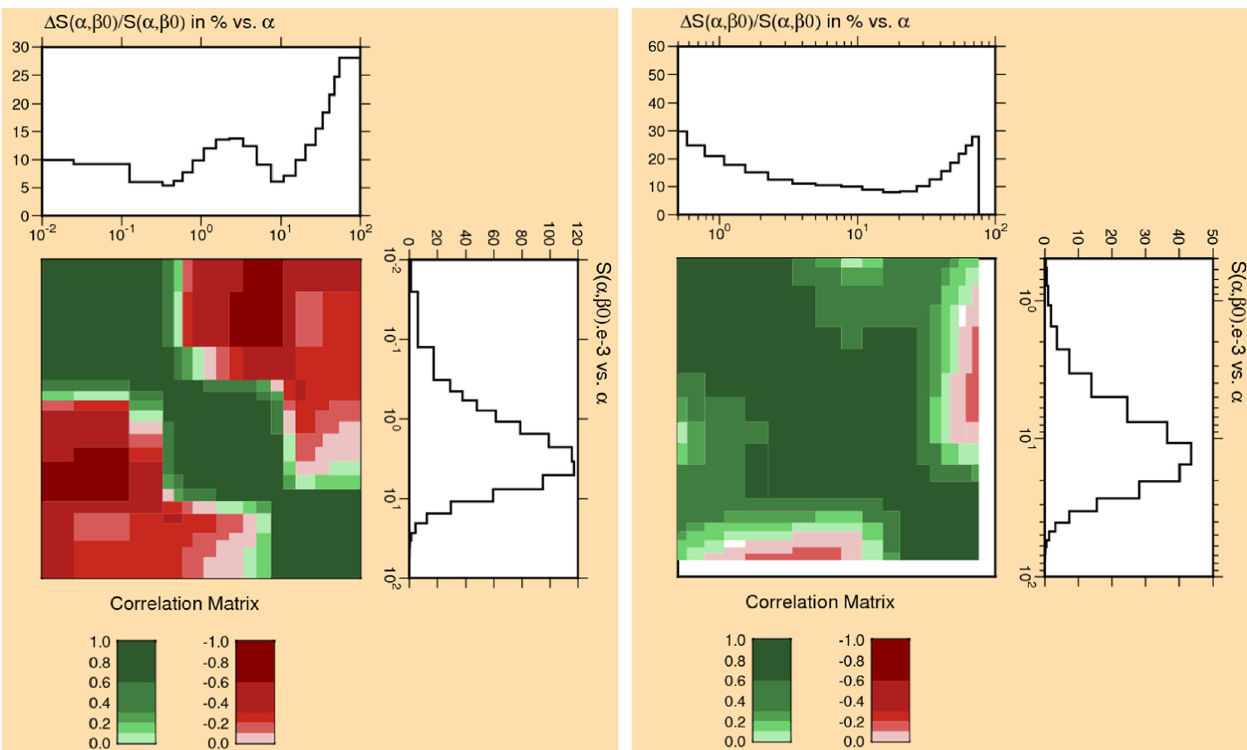
Fig. 6. Relative uncertainties and correlation matrix of the S ð a ; b 0 Þ functions for b =1.0 (left-hand plot) and b =10.0 (right-hand plot) calculated with the CAB model at 294 K with the uncertainties reported in Table